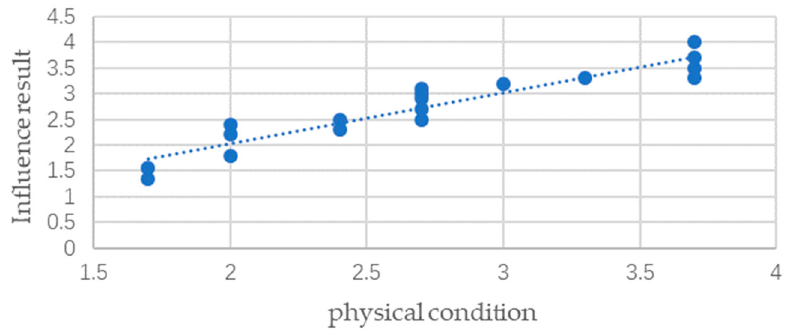
Figure 6. Scatter diagram of physical conditions vs. influence results.